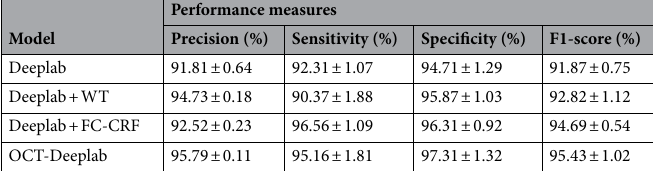
Table 1. Performance comparison between Deeplab with different